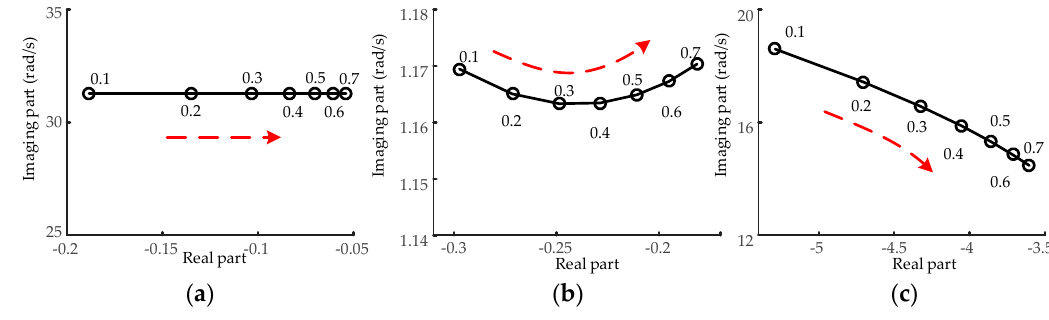
Figure 11. Impact of the distance between the wind farm and the rectifier station ( a ) Tor-1 mode ( b ) Tor-2 mode ( c ) Electro mode.